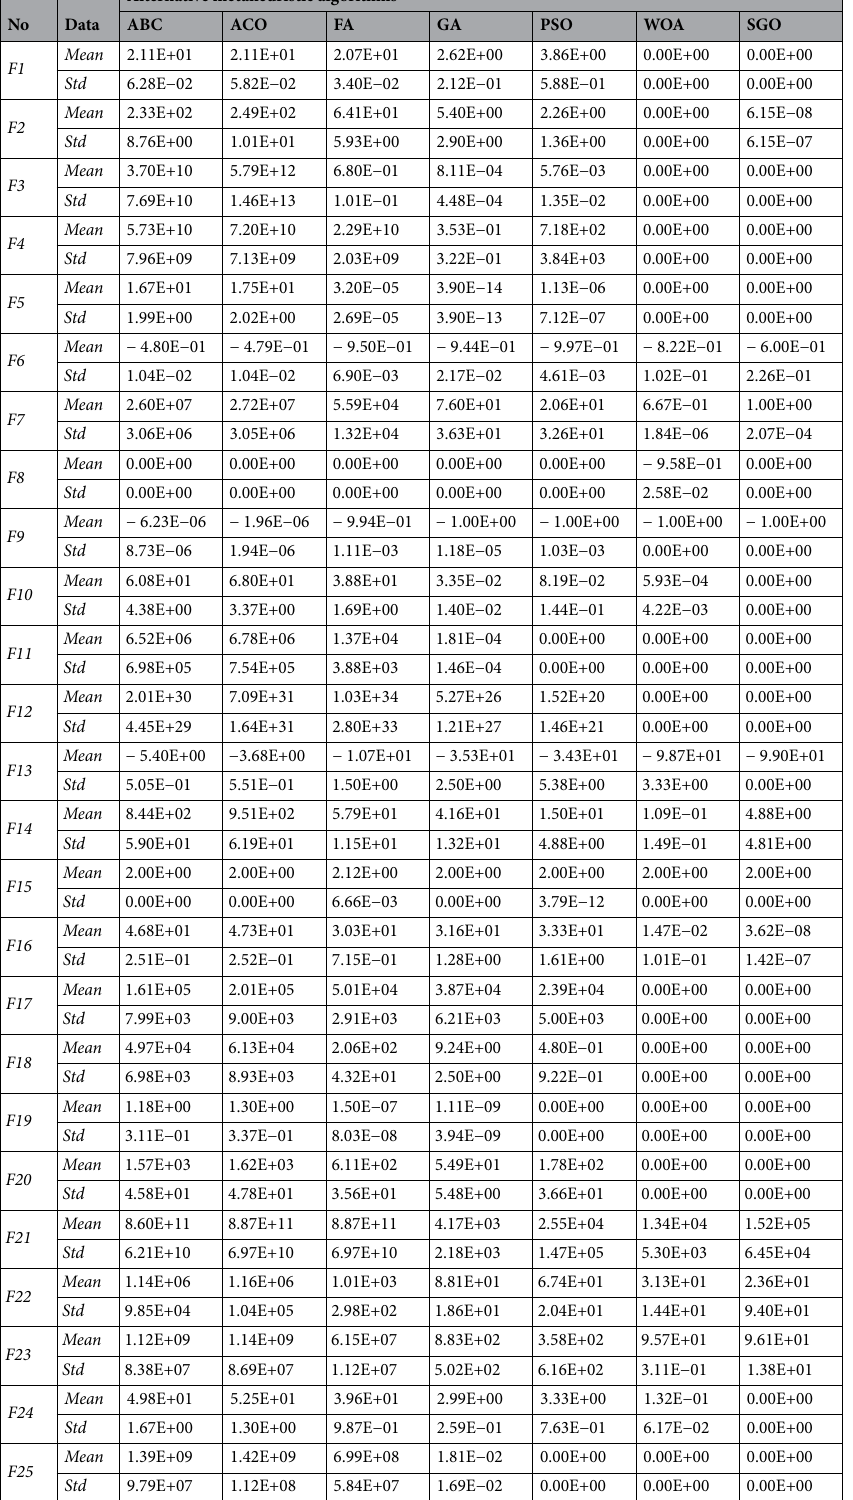
Table 4. The outcomes’ mean and standard deviation for metaheuristic algorithms considering mathematical test